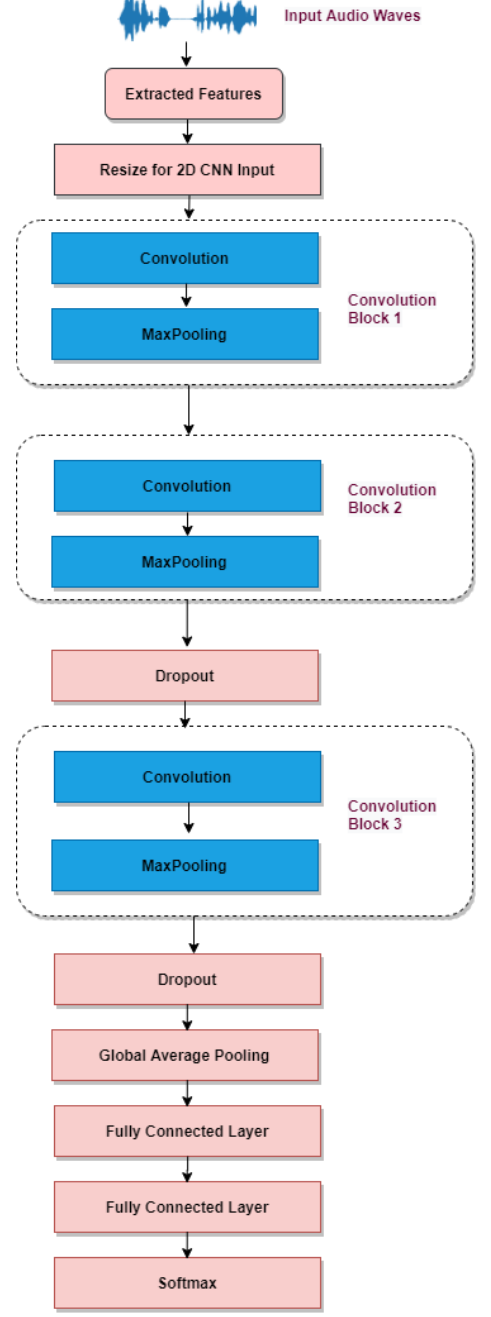
Figure 5. Two-Dimensional CNN.